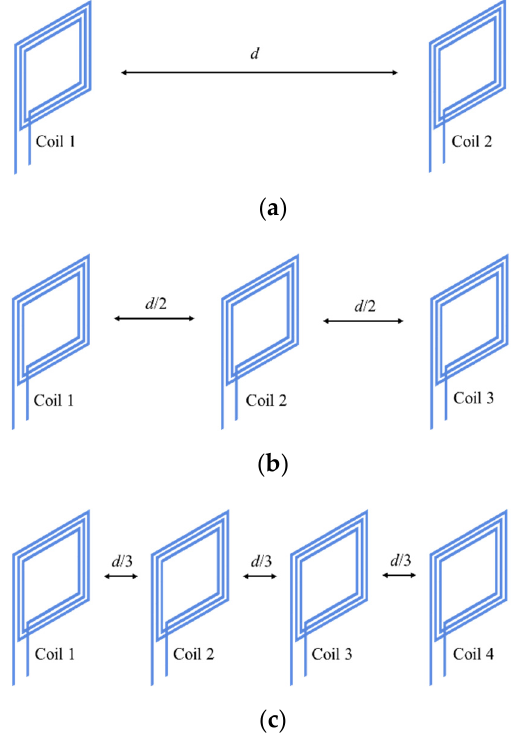
Figure 6. The experimental array of the coils: ( a ) Two coils; ( b ) three coils; and ( c ) four coils. Table 1. The parameter for designed coils.